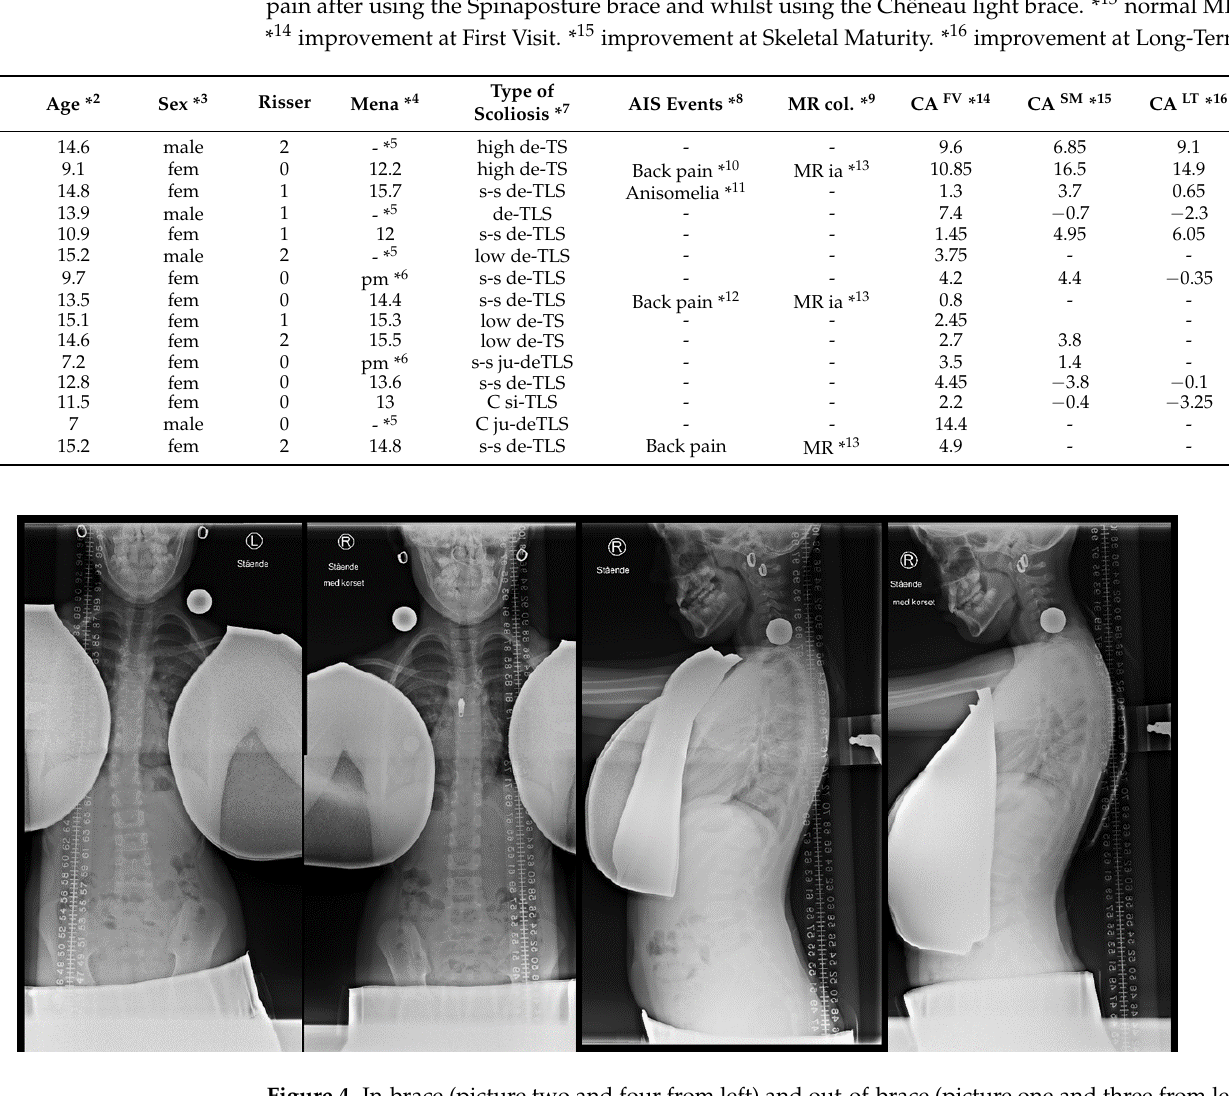
Table 1. Patient Characteristics. * 1 Patient ID. * 2 Age when diagnosed (years). * 3 Gender (fem = female, male = male). * 4 Age of menarche (years). * 5 Not relevant since male. * 6 Pre-menarche.